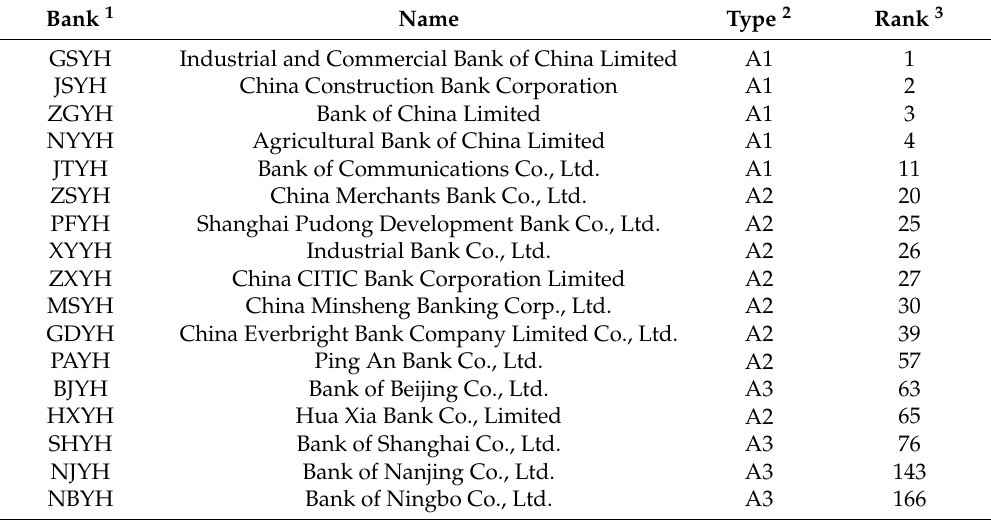
Table 1. The list of the banks in the